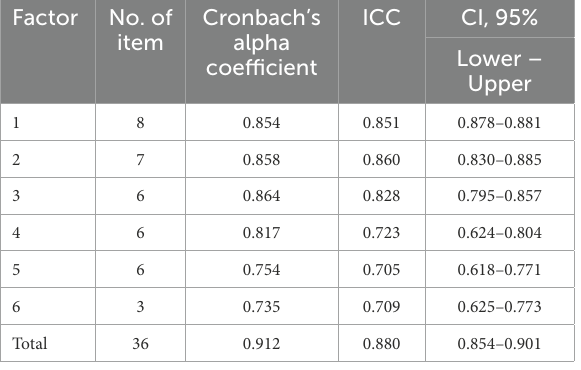
TABLE 3 Reliability coefficient and internal consistency of HCWCIOS.